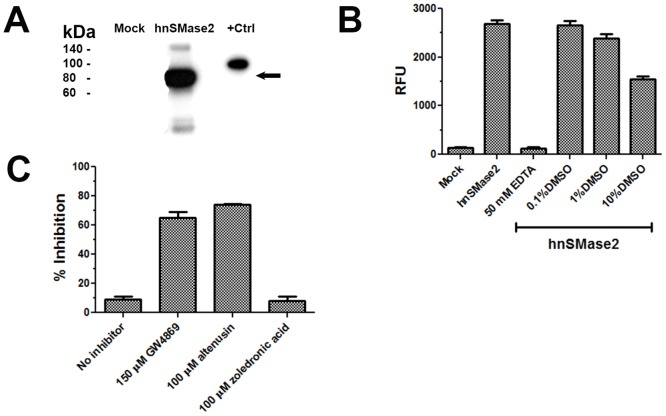
Expression and characterization of recombinant human nSMase2.
(A) Western blot showing expression of recombinant human nSMase2-Flag tagged construct in stably transfected HEK293 cells. Positive control corresponds to GST-tagged human nSMase2 construct commercially available. (B) Human nSMase2 activity dependence with respect to the presence of EDTA and DMSO. (C) Modulation of enzymatic activity by known nSMase inhibitors (GW4869 and altenusin) and by a prototype aSMase specific inhibitor (zoledronic acid). Concentration of GW4869 is a nominal concentration based on dilutions from the stock solution; due to the low aqueous solubility of GW4869, the actual concentration is likely lower than 150 μM.